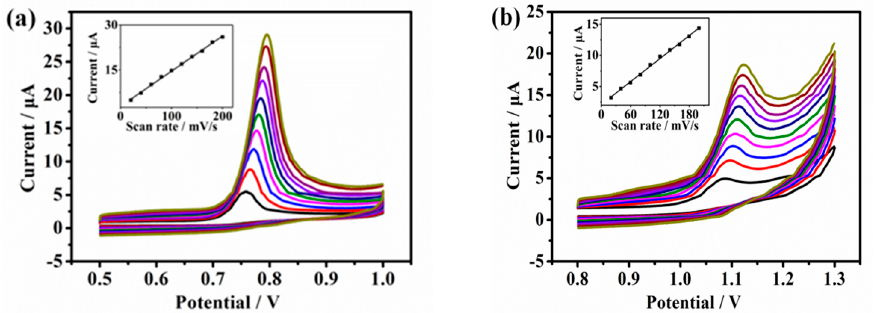
Figure 4. ( a ) CVs of p-Gly/rGO/GCE after adding 20 μ M XT at the scanning rates of 20–200 mV·s –1 in 0.1 M PBS (pH 7.0). Inset: the correlated calibration plot. ( b ) CVs of p-Gly/rGO/GCE after adding 20 μ M HX at the scanning rates of 20–200 mV·s –1 in 0.1 M PBS (pH 7.0). Inset: the correlated calibration diagram.